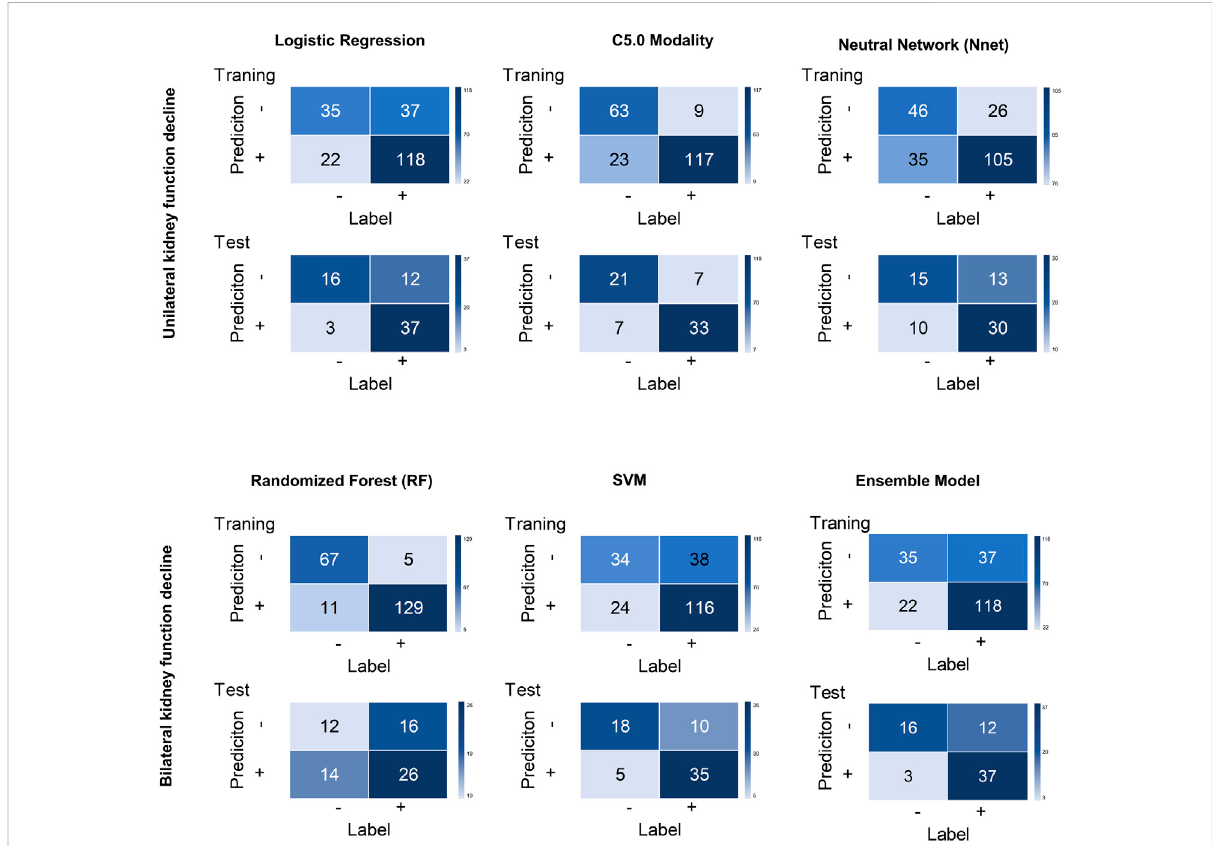
FIGURE 5 Confusion matrices for all models across the training and test cohort. Logistic regression (LR), decision tree (C5.0), SVM, neural network (Nnet), Random Forest (RF) RF and ensemble models were unutilized